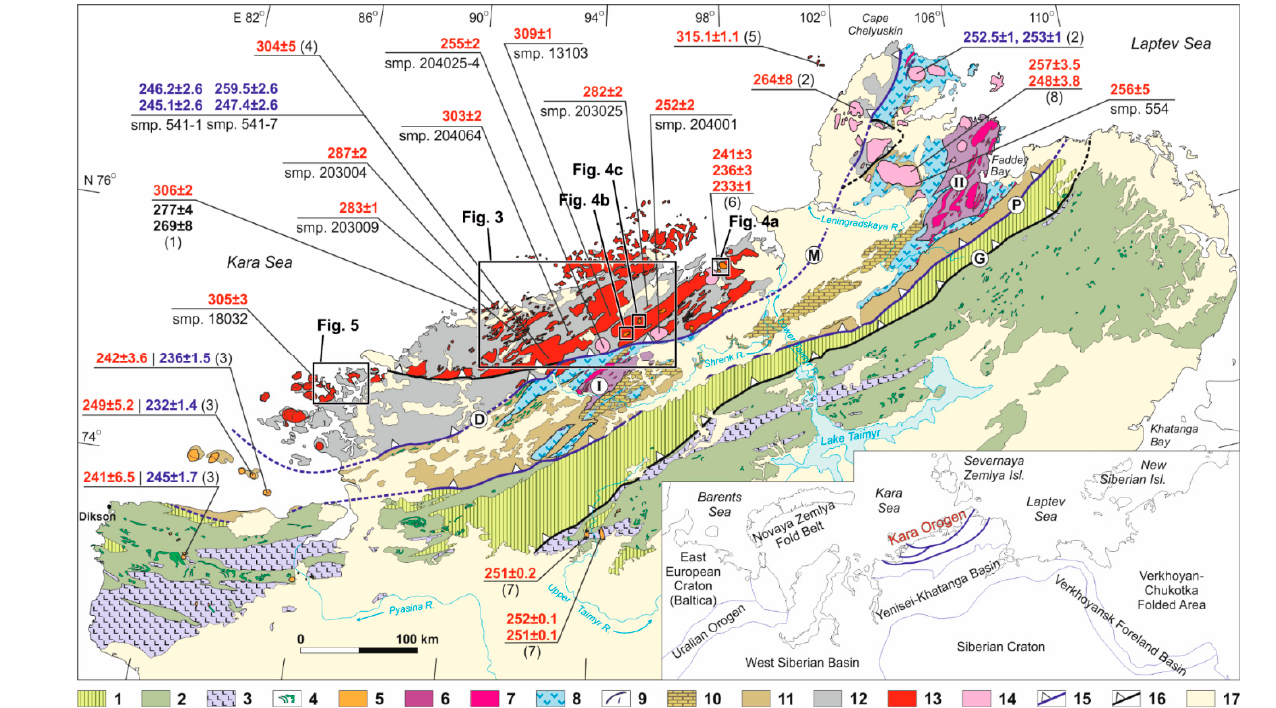
Figure 1. Tectonic map of the Taimyr Peninsula part of the Kara orogen simplified from [10] with tectonic zoning from [12,13,17]. 1–2—Southern Domain–South Taimyr fold belt (deformed passive continental margin of Siberia): 1—mainly dolomites and limestones (O–C 2 ); 2—mainly sandstones, mudstones, coal bearing deposits (C 3 –P 2 );